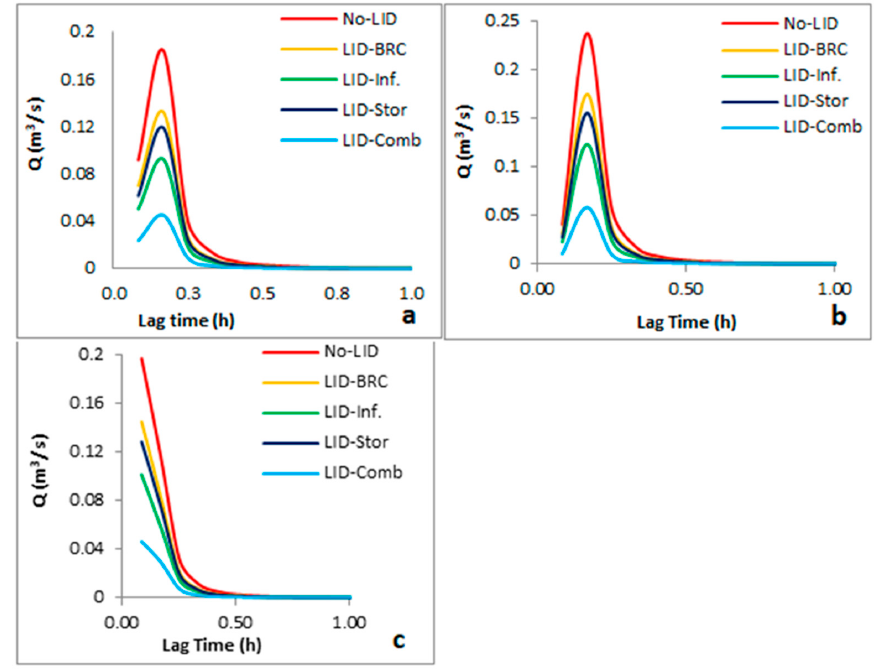
Figure 6. Effect of various LID scenarios on 10 min rainfall of: ( a ) rainfall pattern TS1; ( b ) rainfall pattern TS2 and ( c ) rainfall pattern TS3.